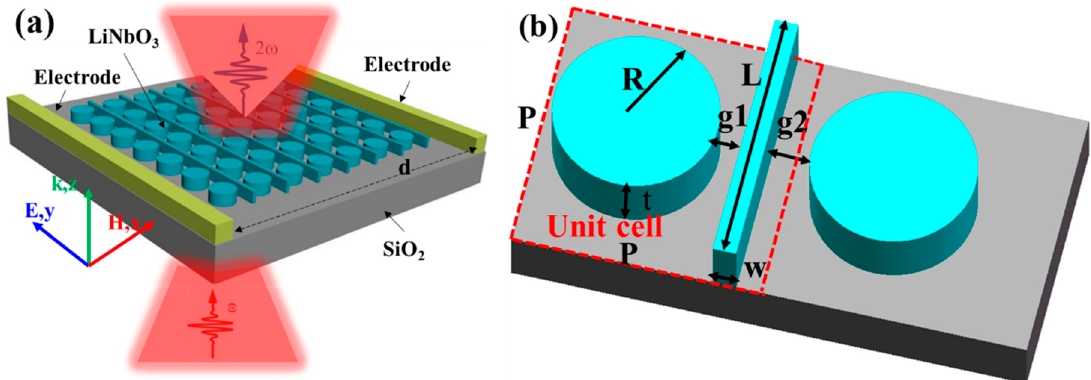
Figure 1. ( a ) Schematic of the TFLN periodic structure configuration for the Second Harmonic Generation (SHG). The distance of the electrodes is d . ( b ) Dashed square is one of the basic ‘meta atom’. The pitch of the meta-atom is P , the radius of the lithium niobate (LN) disk is R , and the thickness of the TFLN is t . The width and length of the LN bar is w and L , respectively.